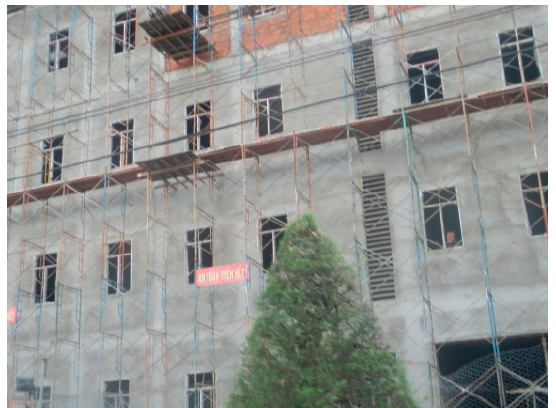
Figure 2. Tra Noc Industrial Zone in Can Tho City. The zone is home to industrial firms producing electronic, food processing, automotive, construction materials and pharmaceutical products.